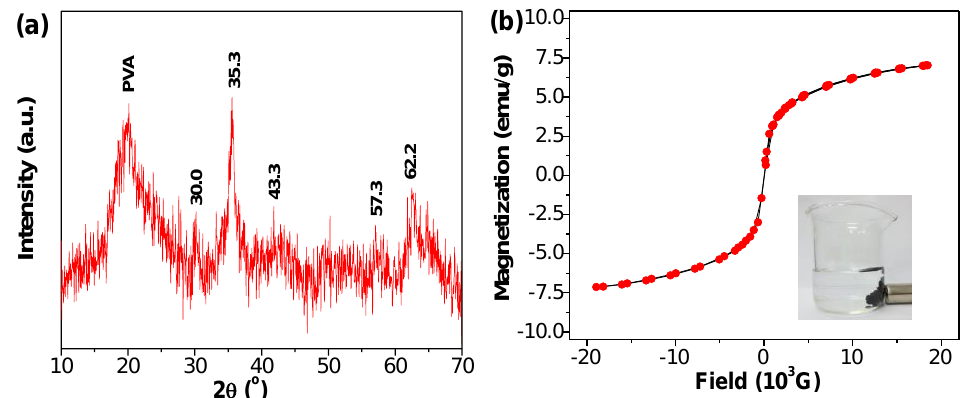
Figure 3. ( a ) Powder XRD pattern of mPVA/AC CG. ( b ) Magnetization curve (300 K) of mPVA/AC CG. Inset: photograph of mPVA/AC CG beads in water after placement of a magnet.